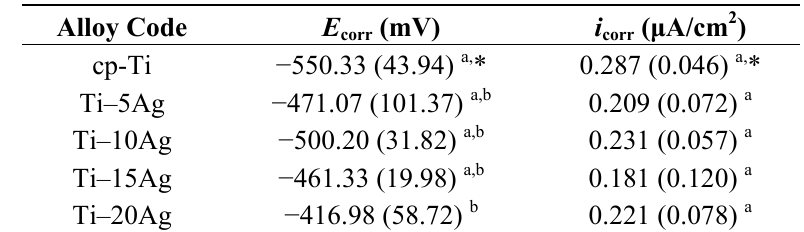
Table 2. Corrosion potential ( E alloys ( n = 3).